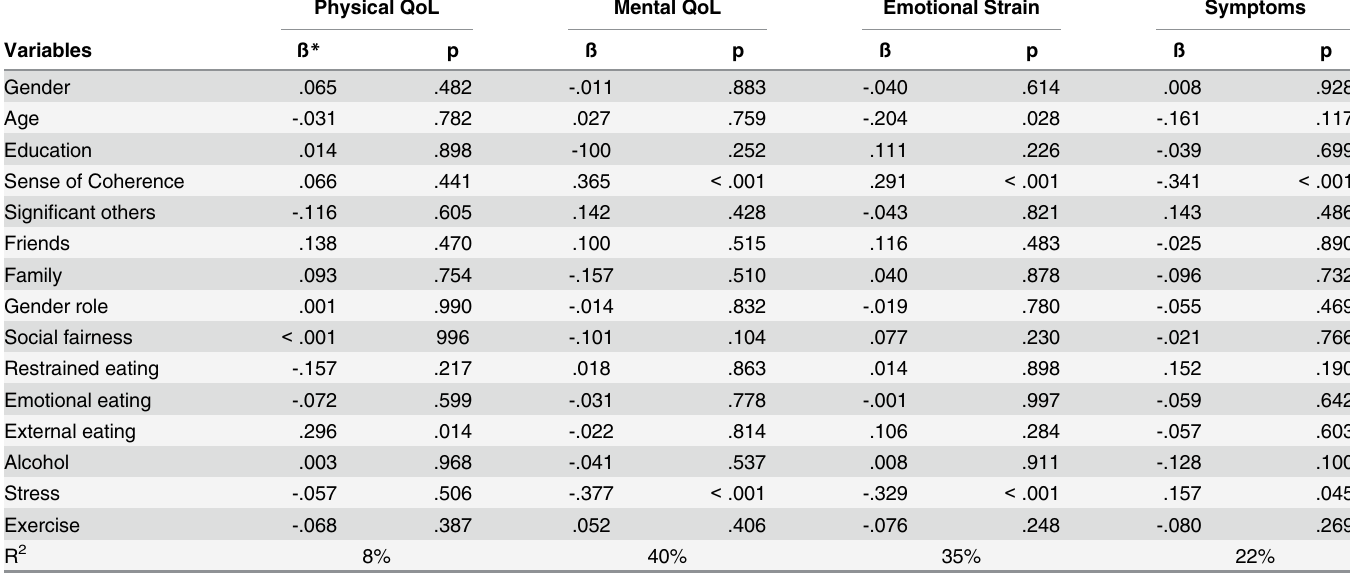
Table 3. Associations between quality of life, emotional strain, symptoms and predictor variables — Japanese